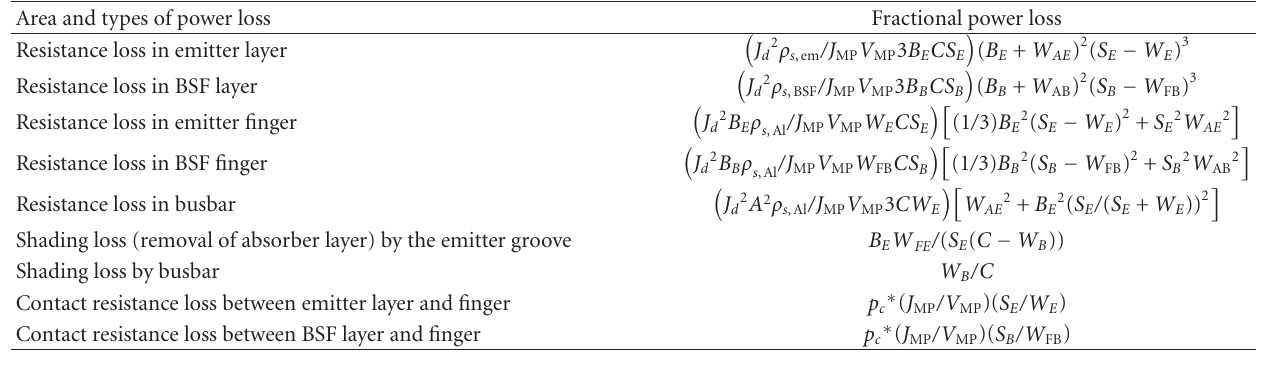
Table 1: Area and types of power loss with formulas.